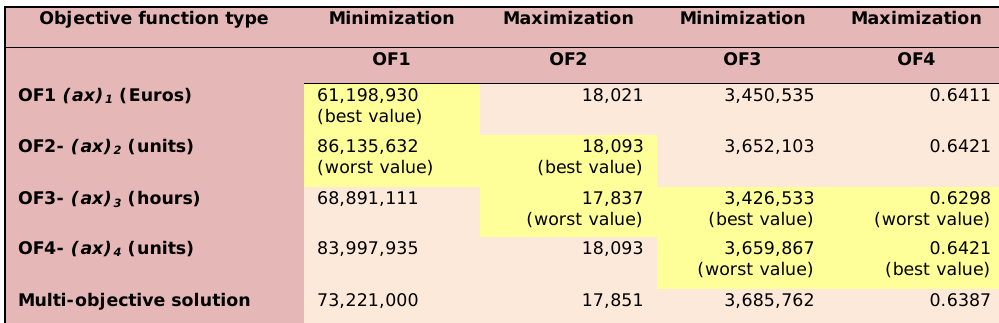
Table 3. Best and worst values for objective functions